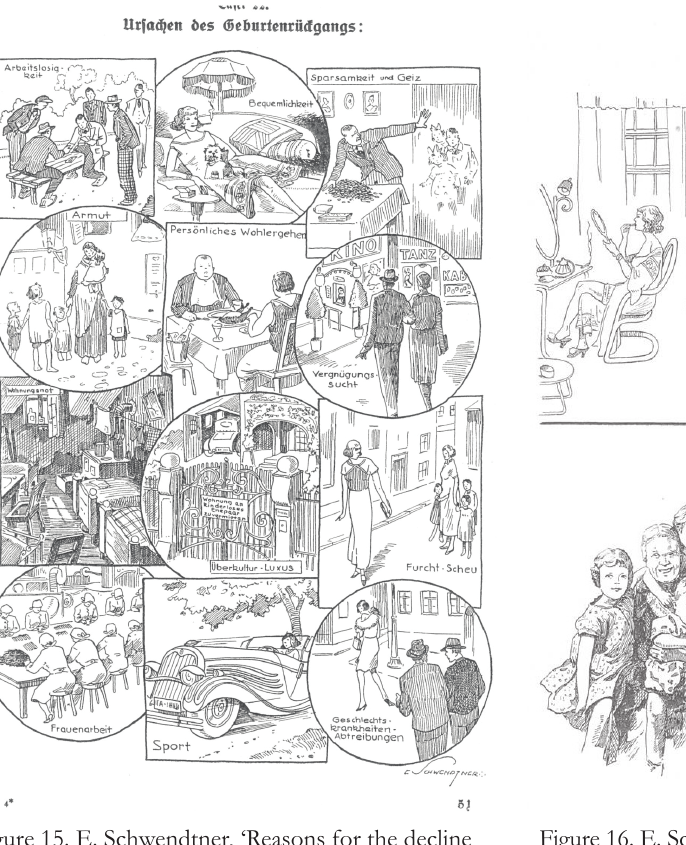
Figure 15. E. Schwendtner, ‘Reasons for the decline of the birth rate’ in: Otto Helmut, Volk in Gefahr (München: Lehmanns Verlag, 1933)